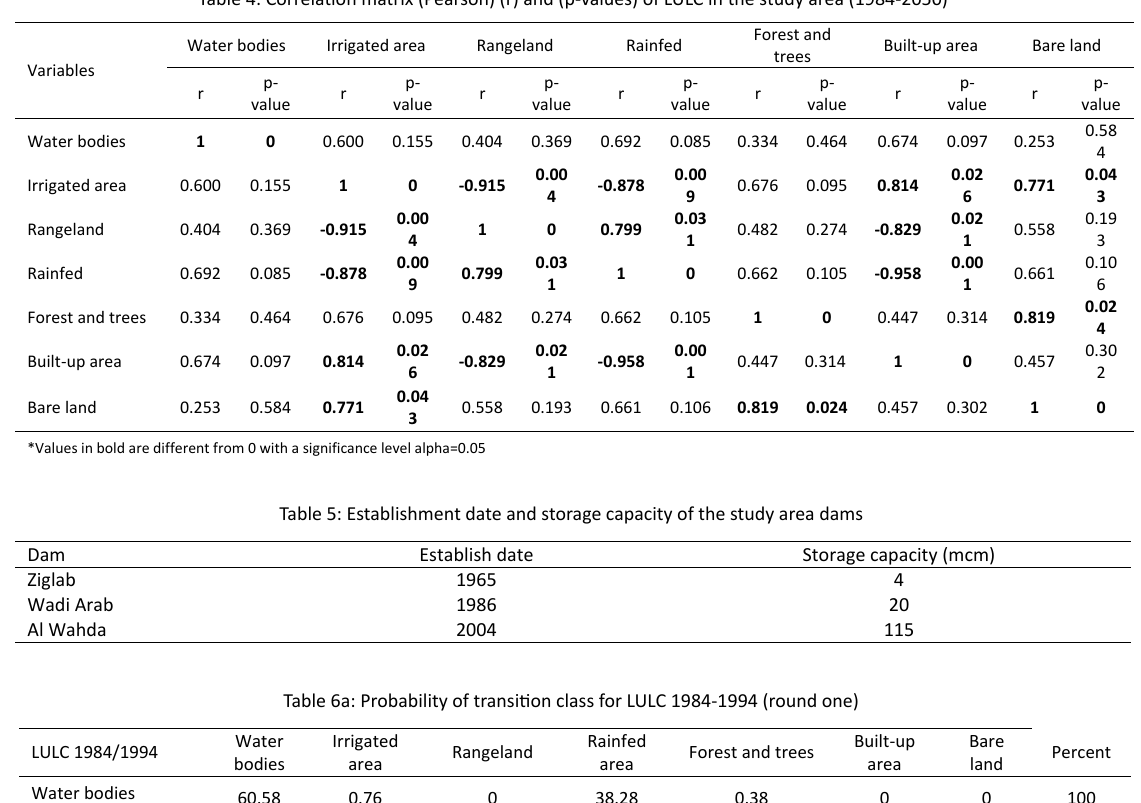
Table 4: Correlation matrix (Pearson) (r) and (p-values) of LULC in the study area (1984-2050)